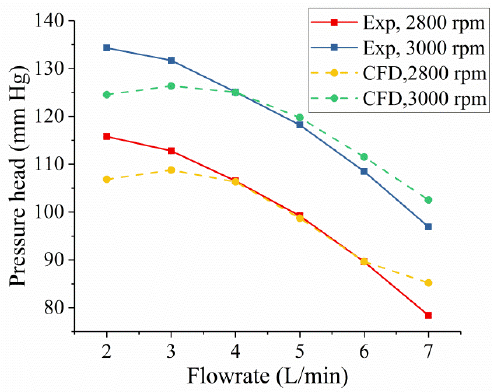
Figure 5. Comparison between the experimental and simulation results of the H–Q curve.